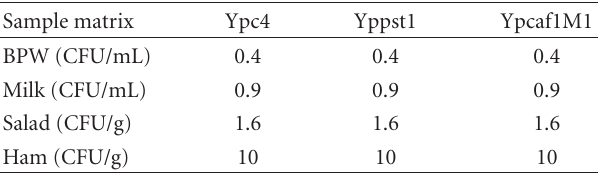
Table 1: Detection limits of Y. pestis KIM5- in experimentally inoculated food matrices using IMS and